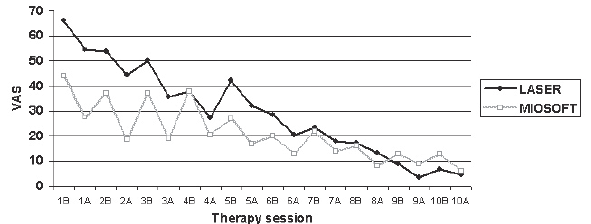
FIGURE 1- Visual Analogue Scale for each study group, before and after each therapy session